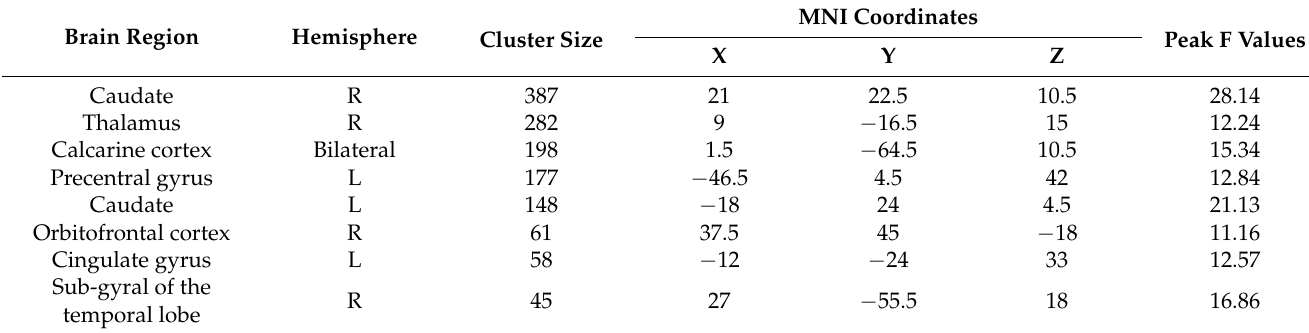
Table 2. GMV differences among groups.